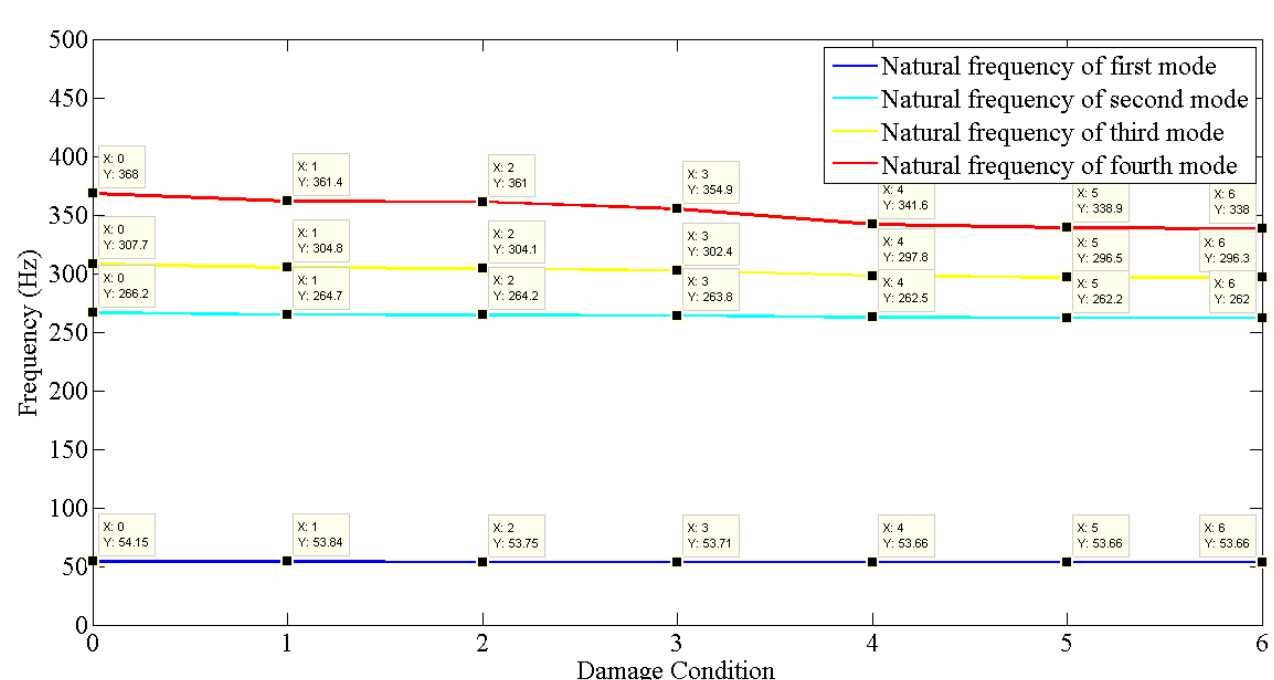
Figure 12. Reduction in frequencies of first four modes of vibration.